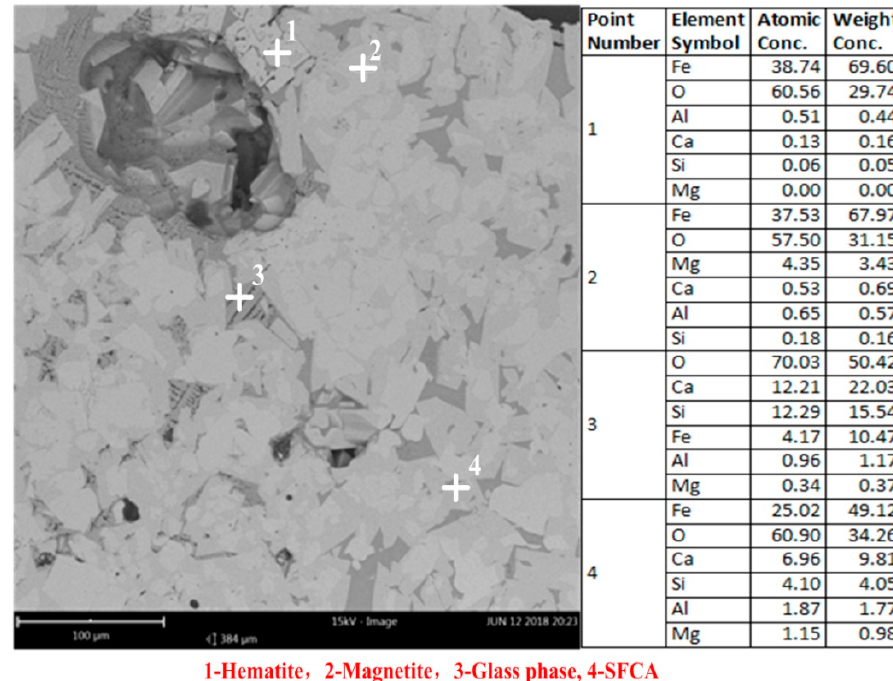
Figure 5. Distribution of MgO in different minerals inside the sinter with 3.10% MgO.